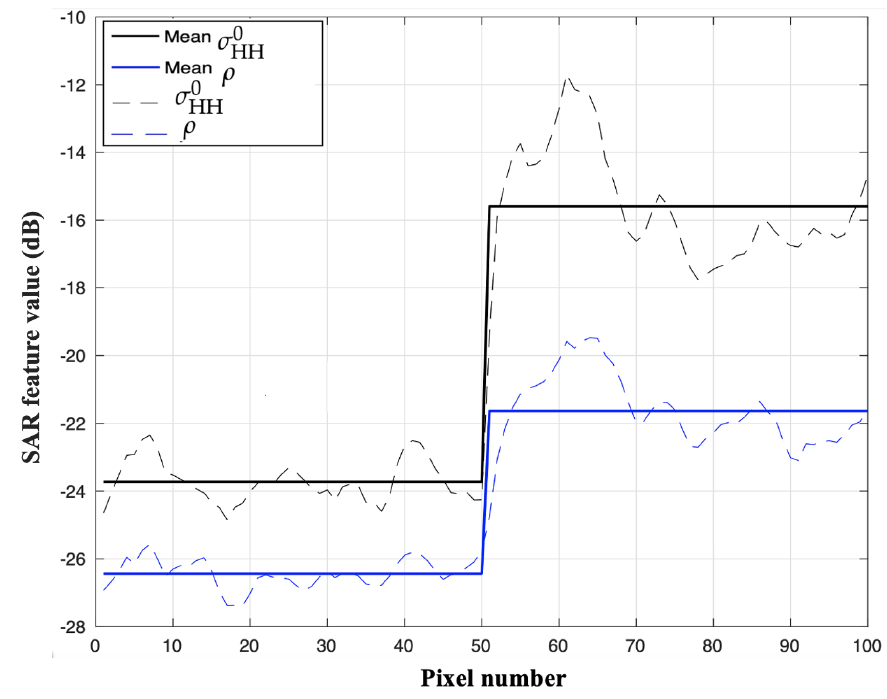
Figure 5. Unfrozen case. Dashed lines refer to σ 0 (black) and ρ (blue) values evaluated as an average HH over the four transects shown with red dashed lines in Figure 3a,d. For reference purposes, the σ 0 HH (black) and ρ (blue) mean values estimated for the sea and glacier ROIs (see Table 2 and Figure 3a,d) are depicted as continuous